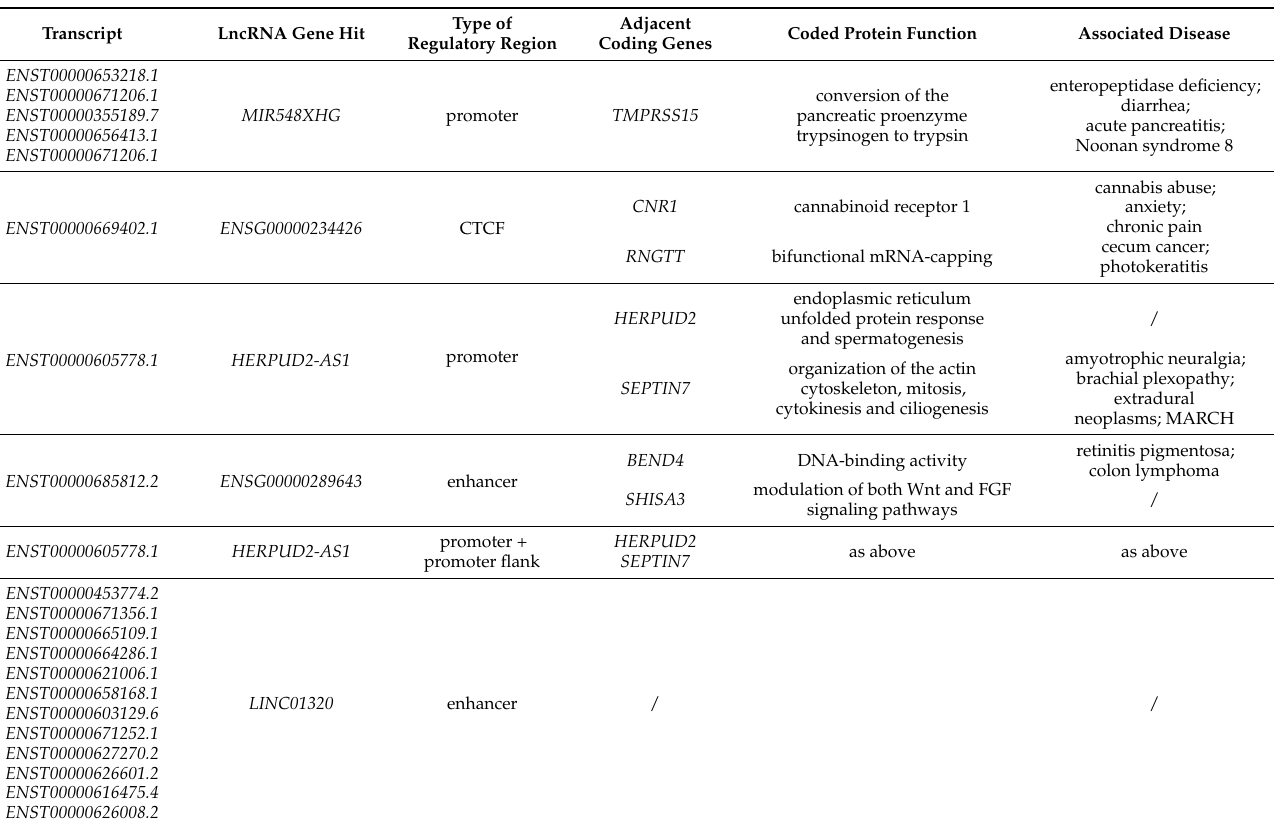
Table 1. LncRNAs having a complementary sequence to the syncytin-1 gene in a regulatory region, and features of adjacent protein-coding genes (ATF7IP: activating transcription factor 7 interacting protein; BEND4: BEN domain-containing 4; CNR1: cannabinoid receptor 1; CTCF: CCCTC-binding factor; FGF: fibroblast growth factor; GRIN2B: glutamate ionotropic receptor NMDA-type subunit 2B; HERPUD2: homocysteine-inducible, endoplasmic reticulum stress-inducible, ubiquitin-like domain member 2; lncRNA: long noncoding RNA; MARCH: multinucleated neurons, anhydramnios, renal dysplasia, cerebellar hypoplasia and hydranencephaly; PM20D1: peptidase M20 domain-containing 1; RNGTT: RNA guanylyltransferase and 5’-phosphatase; SHISA3: Shisa family member 3; TMPRSS15: transmembrane protease serine 15; Wnt: wingless-related integration